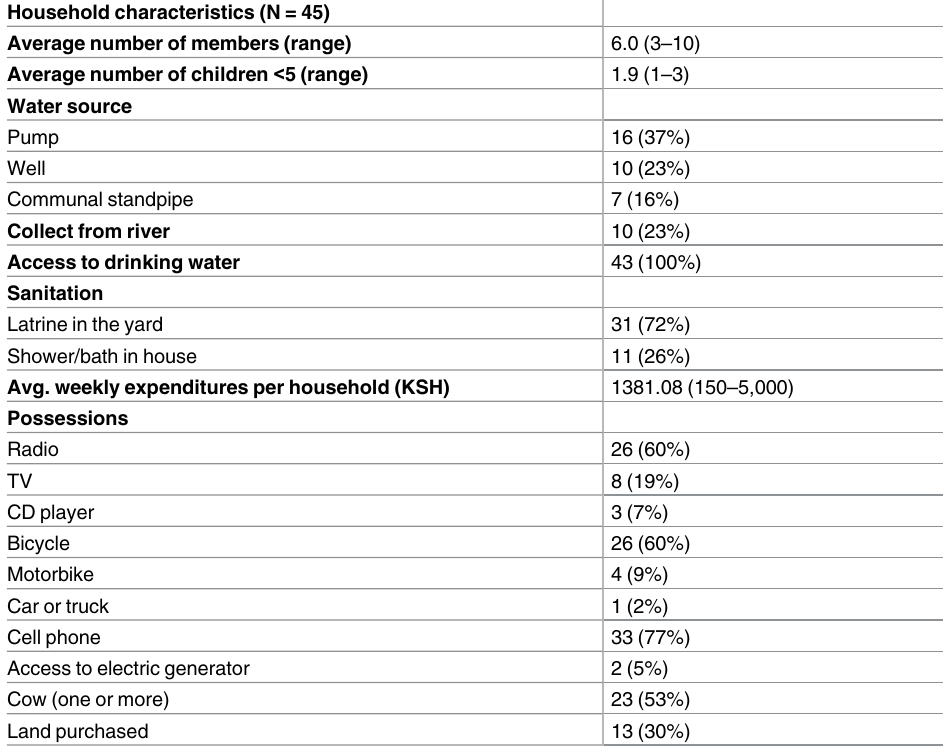
Table 1. Characteristics of participating households.